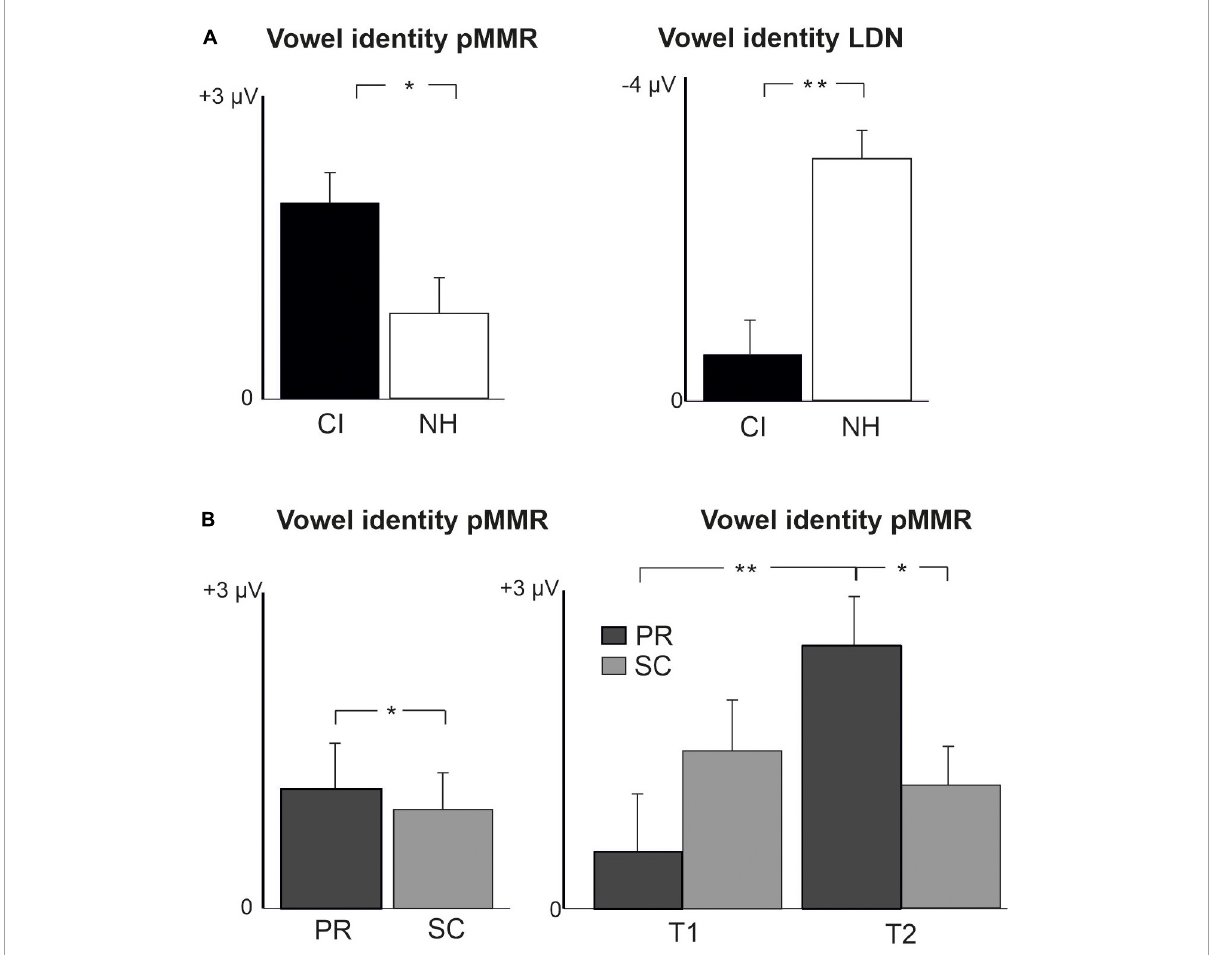
FIGURE4 Barcharts of significant main effects and interactions in Linear Mixed Modeling for the difficult-to-detect change types of vowel identity, F0 and intensity changes. (A) CI vs. NH group main effects; (B) age (preschoolers vs. schoolchildren) main effects and age (preschoolers vs. schoolchildren) and time (measurement 1 and measurement 2) interactions; pMMR, positive mismatch response; LDN, late differentiating negativity; CI, children with cochlear implants; NH, normally hearing children; PR, preschoolers; SC, schoolchildren. * p < 0.05, ** p < 0.01. Note the different scales for different